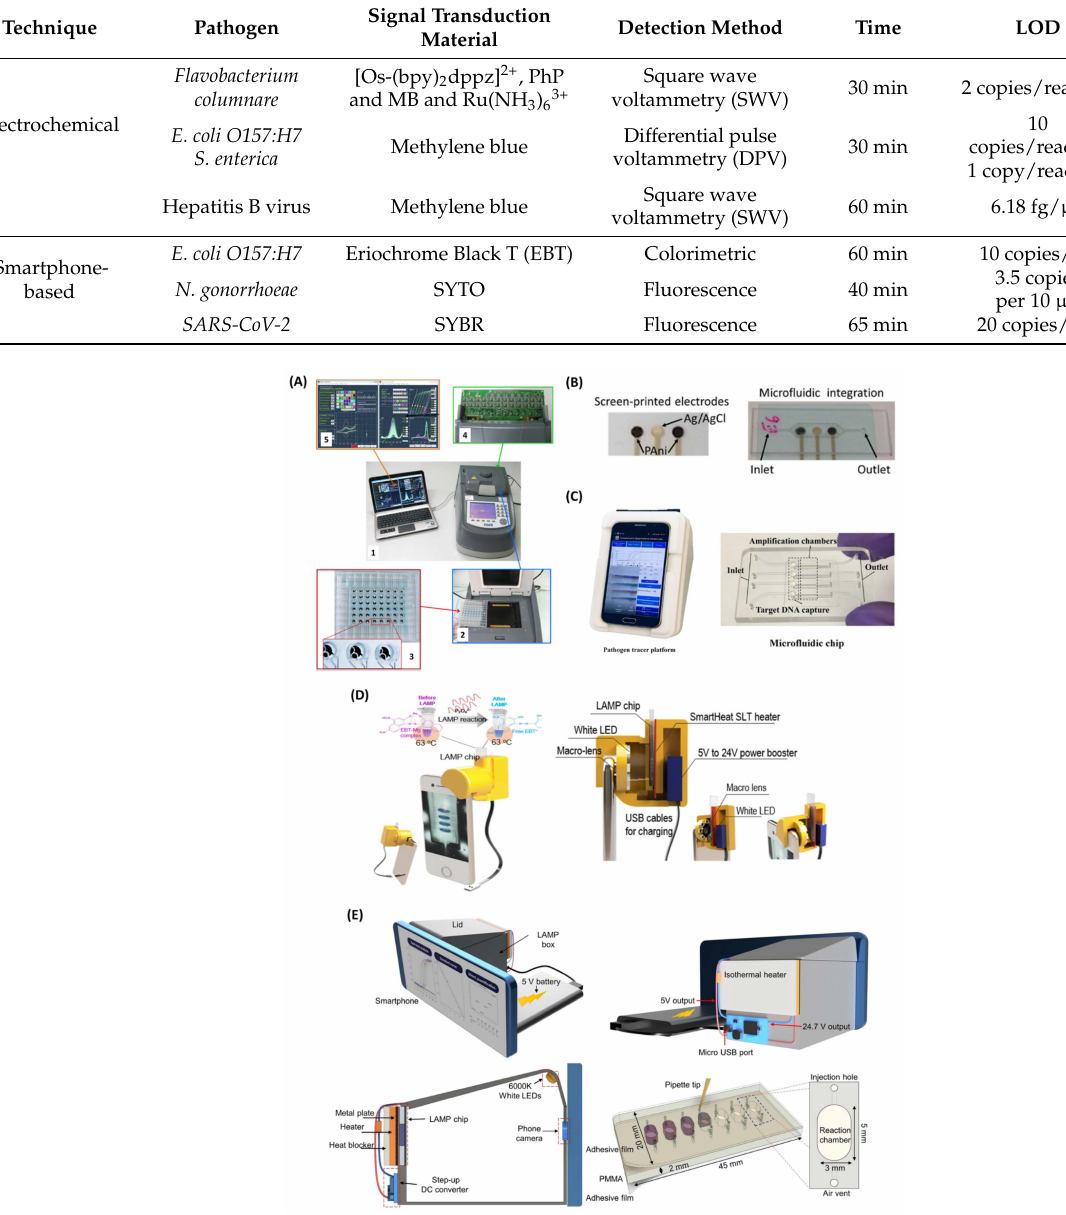
Figure 6. LAMP − based real-time detection modalities. ( A , A1 ) Overview of the electrochemical readout device for real − time monitoring of LAMP reactions; ( A2 ) PCR thermocycler attached with a flat Peltier-heating block with two 72-pin connectors; ( A3 ) electrochemical microplate consisting 48 wells; ( A4 ) PCB interface carrying the multiplexed potentiostat’s electronic circuitry; ( A5 ) specialized software to extract the electrochemical response from each microwell and pilot the PCB interface. ( B ) Screen-printed pH-sensitive polyaniline (PAni)-based electrode for real-time detection of LAMP. ( C ) Hue-based detection of HPV and HIV by a “smart connected pathogen tracer” (SCPT) device. ( D ) Schematic illustration of smartphone-integrated i-Gene analyser and its inside view. ( E ) 3D schematics of i − Genbox for real-time detection of infectious pathogens. Reproduced with